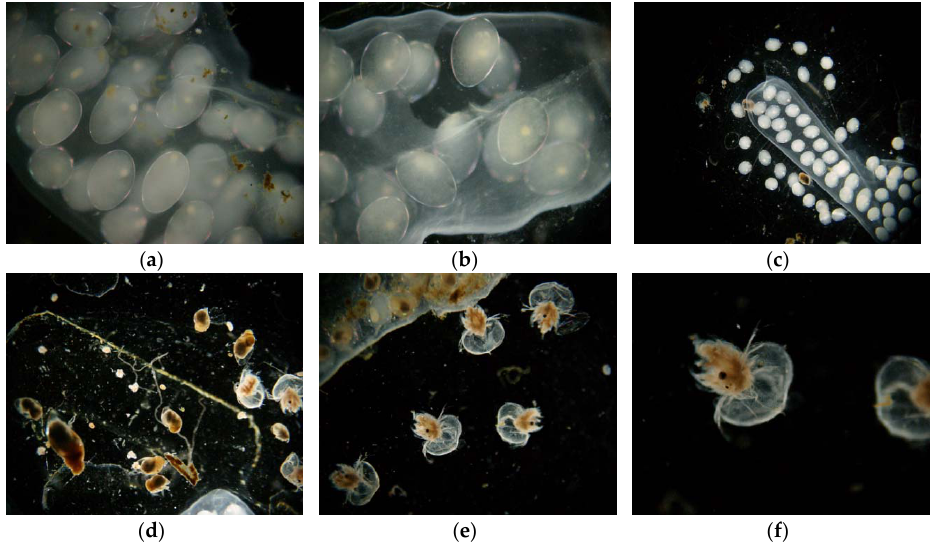
Figure 6. Visible changes caused by the effect of acids on organisms. ( a – c ) Embryos of Lymnaea stagnalis ; ( d ) hatchlings of Lymnaea stagnalis ; and ( e , f ) Daphnia magna .